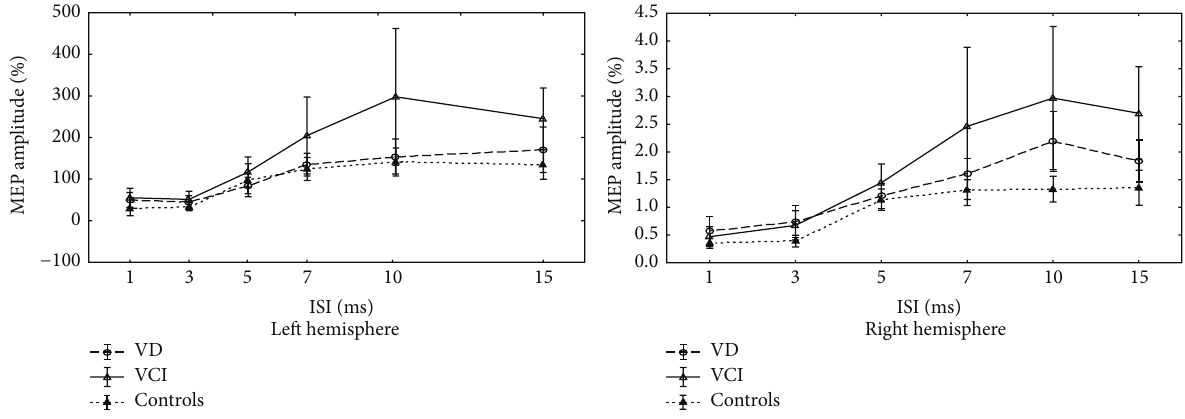
Figure 1: The mean time course of intracortical excitability in the patients and controls at baseline. MEP, motor evoked potential; ISI, interstimulus interval; VD, patients with vascular depression; VCI, patients with vascular cognitive impairment-no